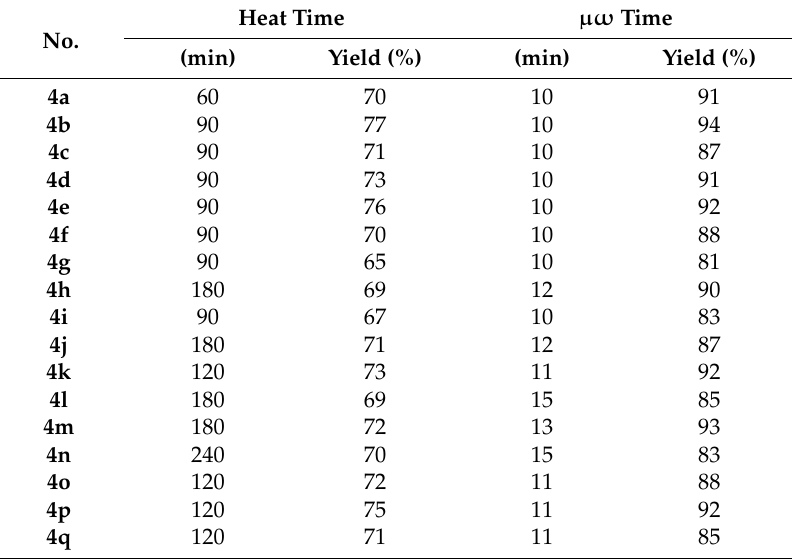
Table 1. Formation of compounds 4a – q under thermal and microwave irradiation. No.